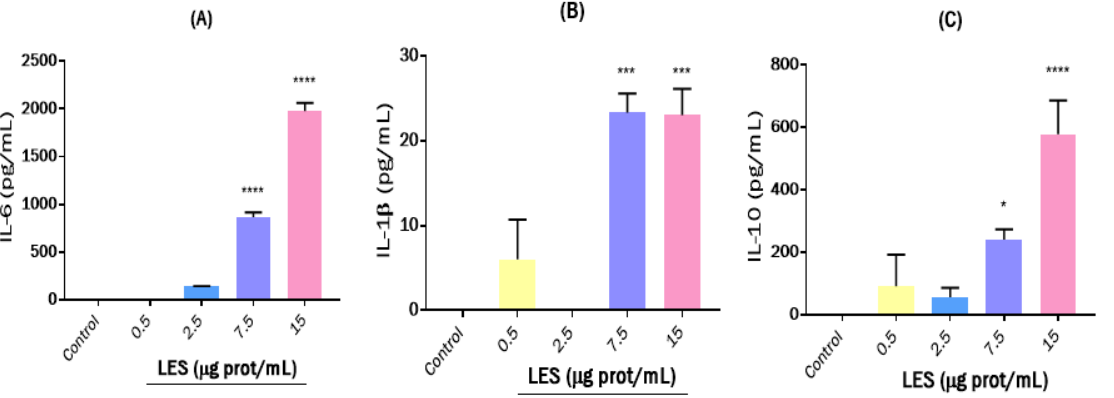
Figure 3. Immunomodulatory effects of lunasin-enriched soybean extract (LES) on RAW264.7 mac- rophages. ( A , B ) Effects of lunasin-enriched extract (LES, 0.5–15 µg protein/mL) on nitric oxide (NO) levels in RAW264.7 cells after ( A ) 8 h and ( B ) 24 h of treatment. ( C , D ) Effects of LES (0.5–15 µg protein/mL) on the phagocytic capacity of RAW264.7 cells after ( C ) 8 h and ( D ) 24 h of treatment. LPS was used as a positive control at a concentration of ( A , B ) 100 ng/mL for NO induction and ( C , D ) 10 ng/mL for phagocytic capacity stimulation. Significant differences compared to control: * p < 0.0001.